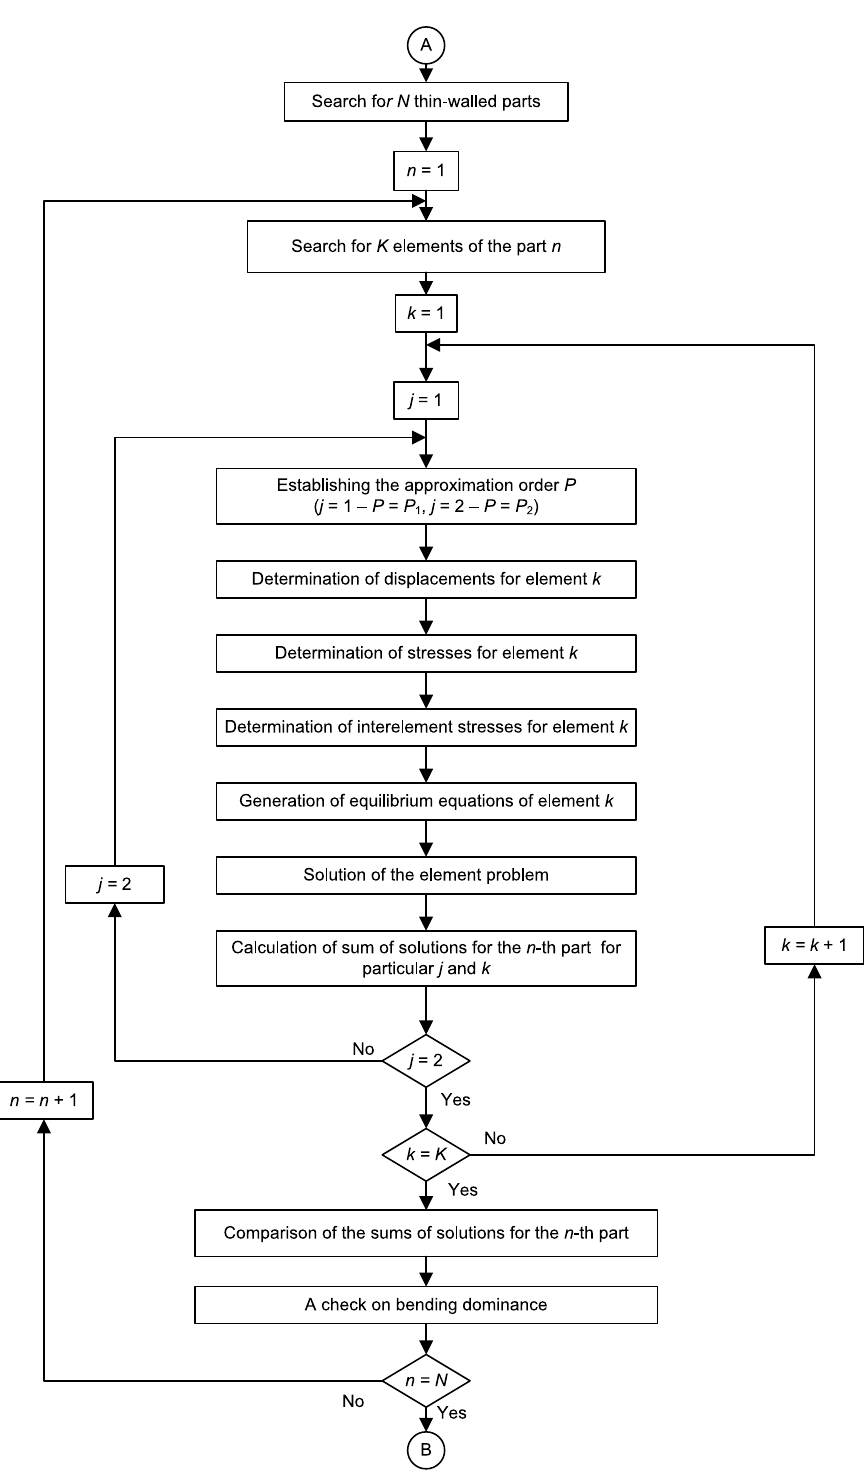
Figure 2. Flow diagram of the overall algorithm for the locking